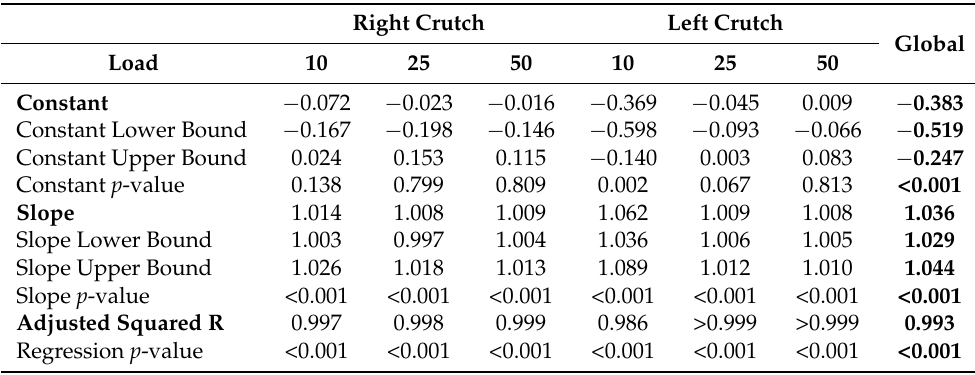
Table 5. Regression analysis for each crutch and the different loads. Right Crutch Left